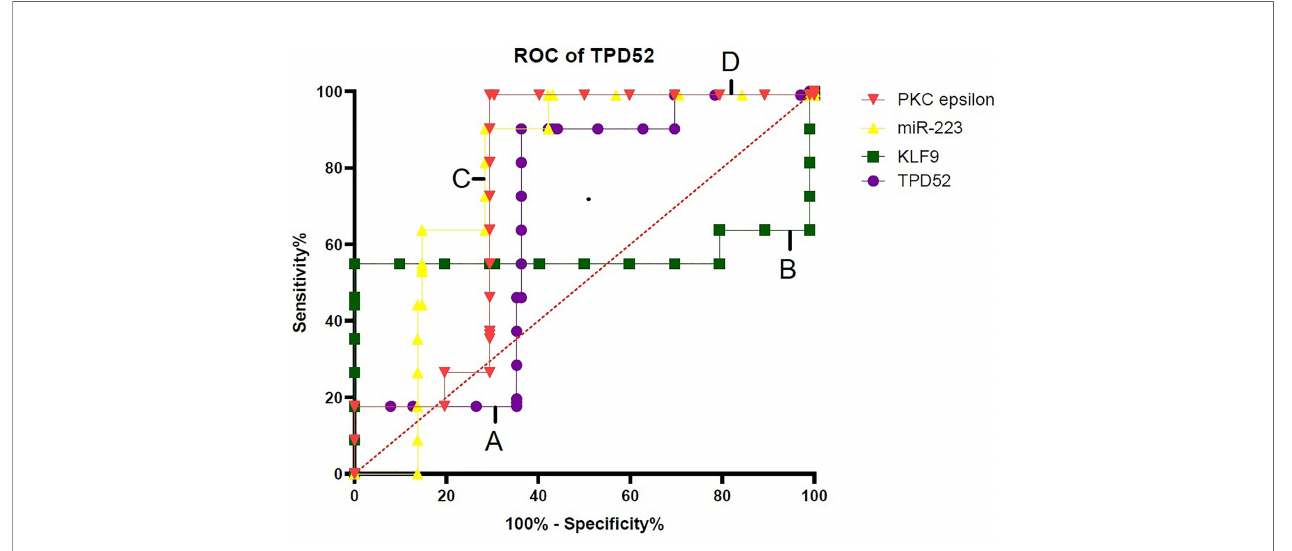
FIGURE 9 | Speci fi city of TPD52 , KLF9 , miR-223, and PKC ϵ in the diagnosisofcervical cancer. Receiver operatingcharacteristic(ROC)curve for TPD52 , KLF9 , miR-223, and PKCe predicted highriskofcervical cancer. (A) TPD52 : area under the ROC curve (AUC) = 0.6685 and 95% con fi dence interval (CI) = 0.5880 – 0.7490. (B) KLF9 : AUC = 0.5706, 95%CI = 0.4775 – 0.6638. (C) miR-223: AUC= 0.7884, 95%CI = 0.7184 – 0.8583. (D) PKC ϵ : AUC= 0.7595, 95%CI = 0.6852 – 0.8338.